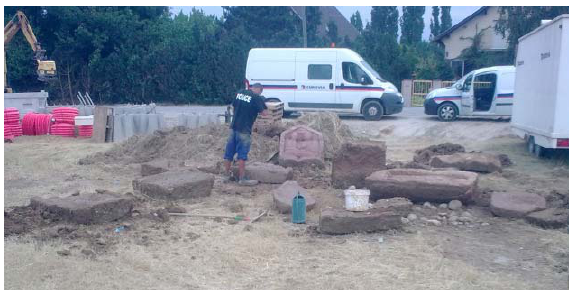
Figure 2: Incidental discovery of funerary stelae during road